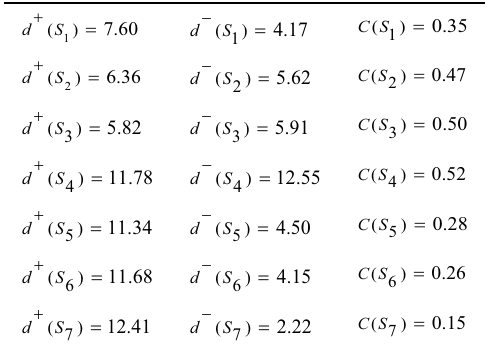
Table 6. Distances and relative degree of closeness